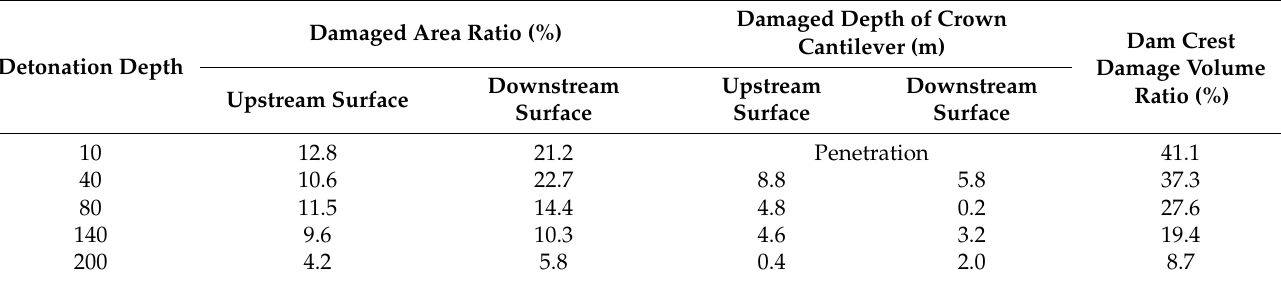
Table 3. Arch dam body damage at various detonation